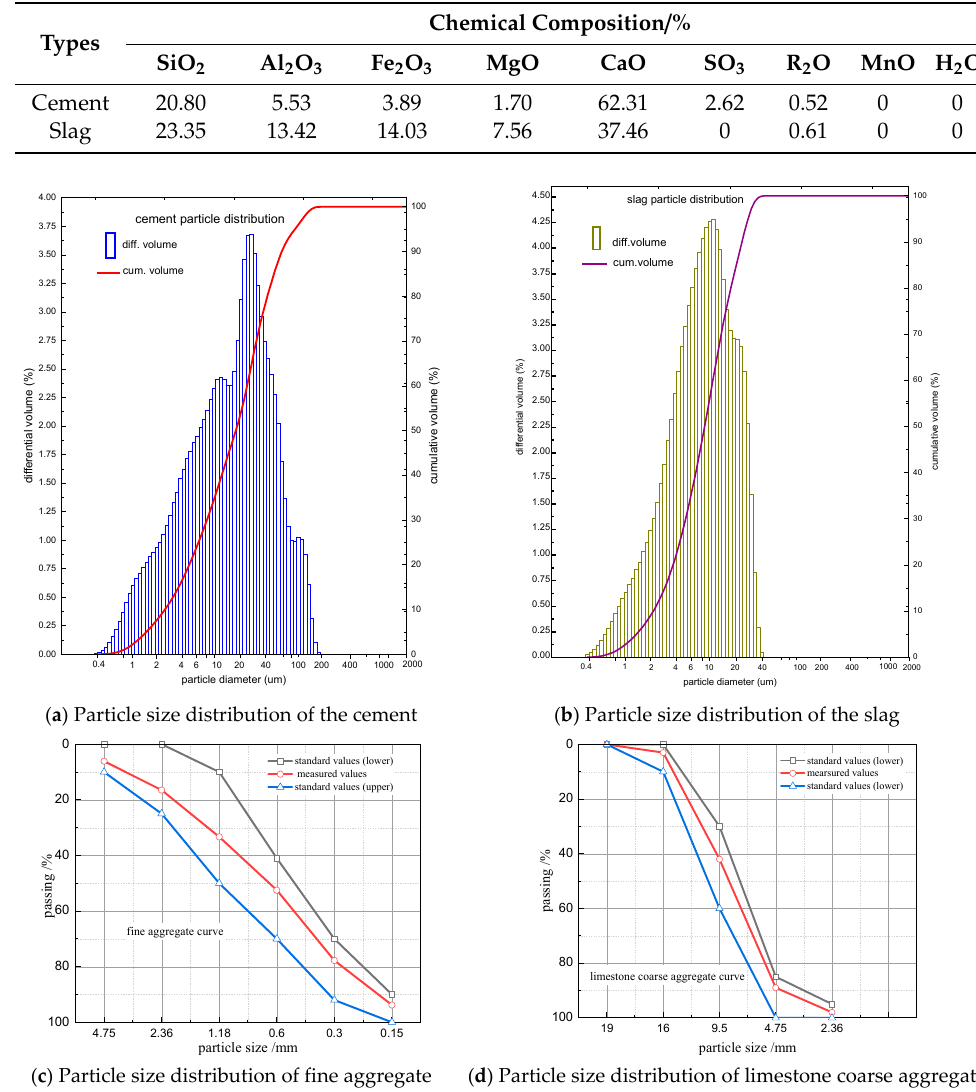
Table 2. Chemical composition of the cement and slag.